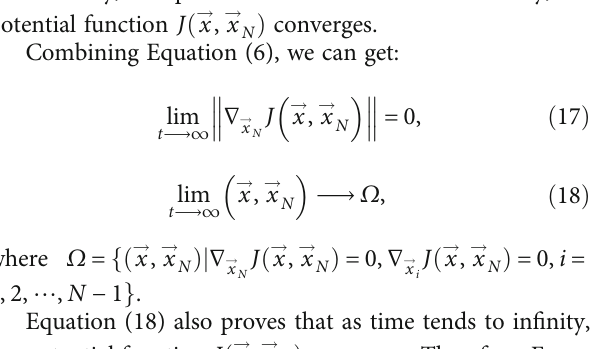
mode observers, a fi rst-order low pass fi lter can be de fi ned as [32, 33].